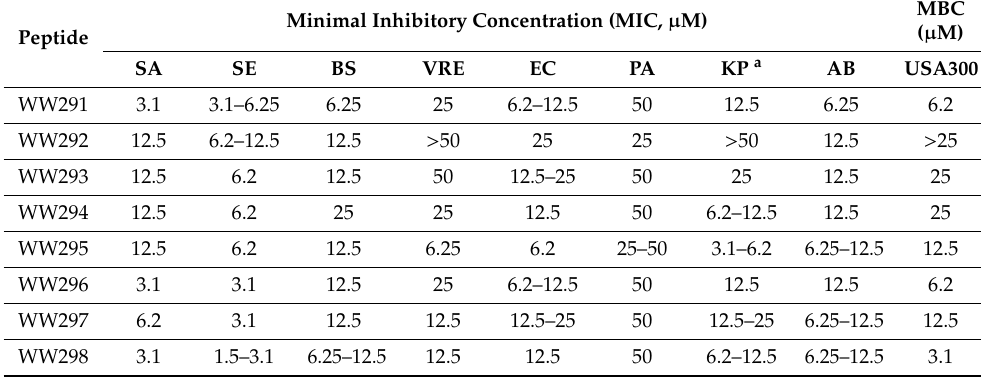
Table 2. Antibacterial activities of the WW peptides against various bacteria.